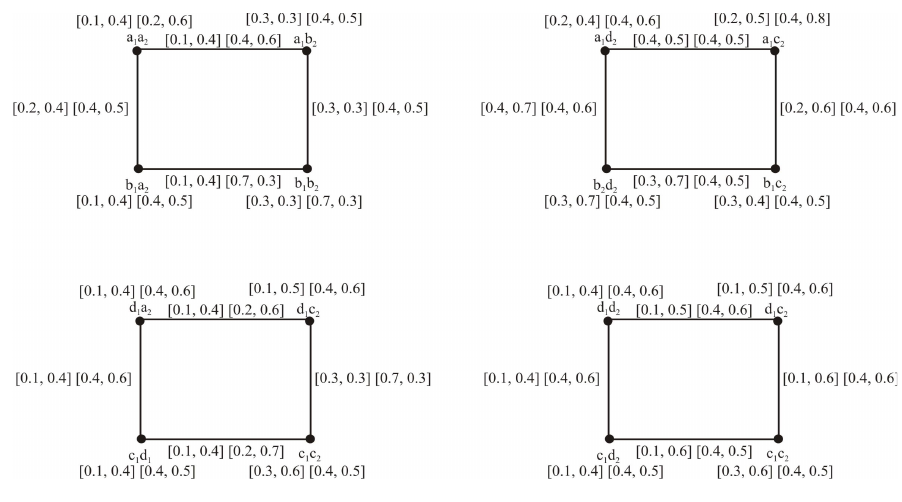
Figure 3: Cross product of ˜ ξ